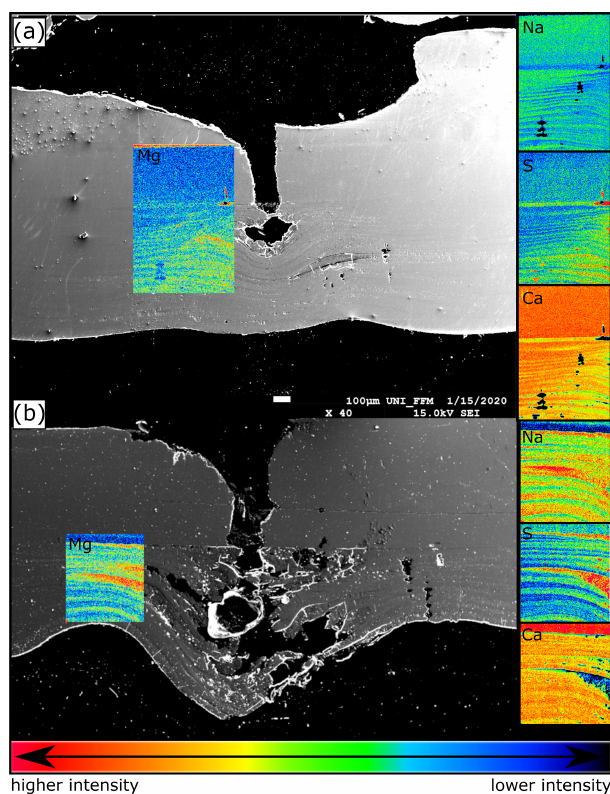
Figure 3. EPMA element maps and secondary-electron image from a scanning electron microscope (SEM) image of the callus area of two specimen (a, b) of A. excavata . Intensity scale in counts per sec- ond (cps). Minimum–maximum counts amount to Mg (10–24cps), Na (76–132cps) Ca (7600–8650cps) and S (8.5–33cps).